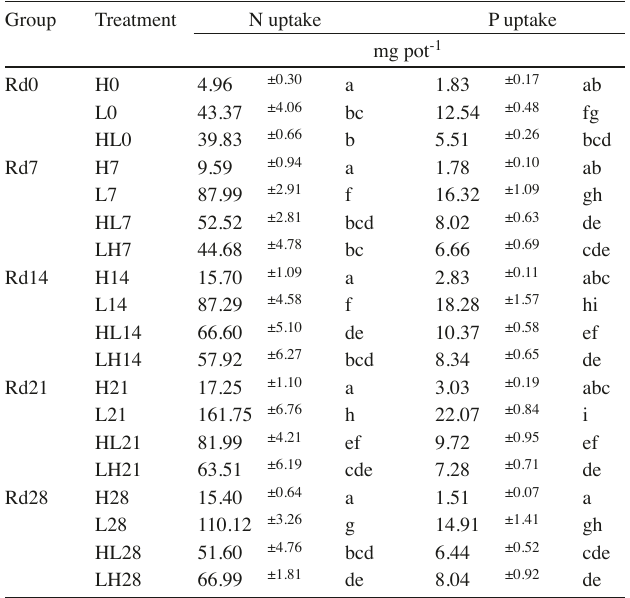
Tab. 5: Shoot N and P uptake per g root of wheat 28 days after the second residue addition in treatments with only high C/N residue added (H), only low C/N residue added (L), high followed by low C/N (HL) or low followed by high (LH) where the second residue was added 7, 14, 21 or 28 days after the first (Rd7, Rd14, Rd21, Rd28) or full residue amount added on day 0 (Rd0)(n=4 ± standard error). Values followed by different letters are significantly different (P≤